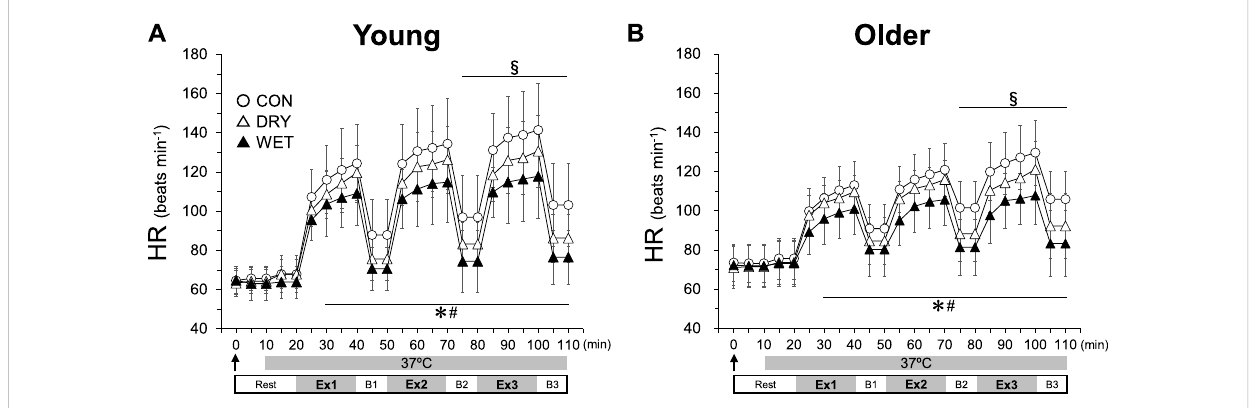
FIGURE 3 Heart rate(HR)responses duringthree boutsofintermittent exercise (Ex1 – 3)inhotconditions (37 ° C,50%RH)interspersedbythreebreaks(B1 – 3)in the young (A) and older (B) groups while wearing a dry inner t-shirt without ventilation garments fanning in the control (CON, open circles), a dry inner t-shirt with ventilation garment fanning (DRY, opened triangles), and a wetted inner t-shirt with ventilation garment fanning (WET, closed triangles). The arrow indicates the start of fanning (DRY) and wetting and fanning (WET). *Signi fi cantly different for CON vs. WET trial, p < 0.05. #Signi fi cantly different for DRY vs. WET trial, p < 0.05. §Signi fi cantly different for CON vs. DRY trial, p < 0.05. Data are expressed as the mean ± SD for eight participants.